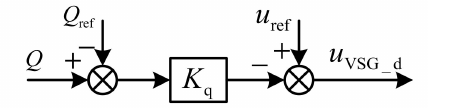
Figure 4. The block diagram of virtual excitation